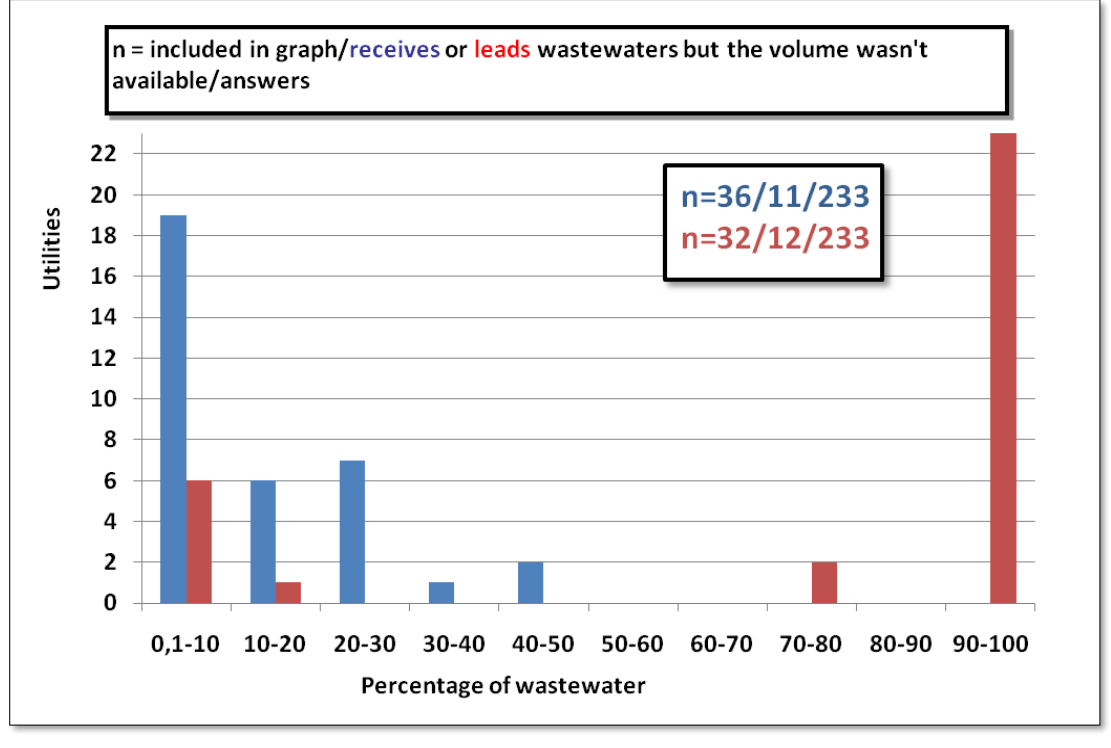
Figure 2. Percentage of wastewater received from or transferred to other municipalities